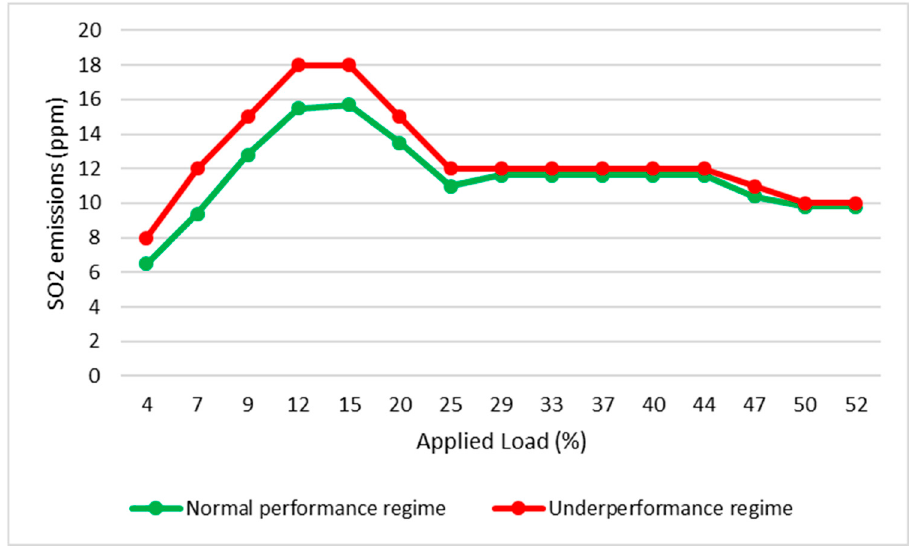
Figure 8. Variation of the SO 2 rate according to the applied loads.